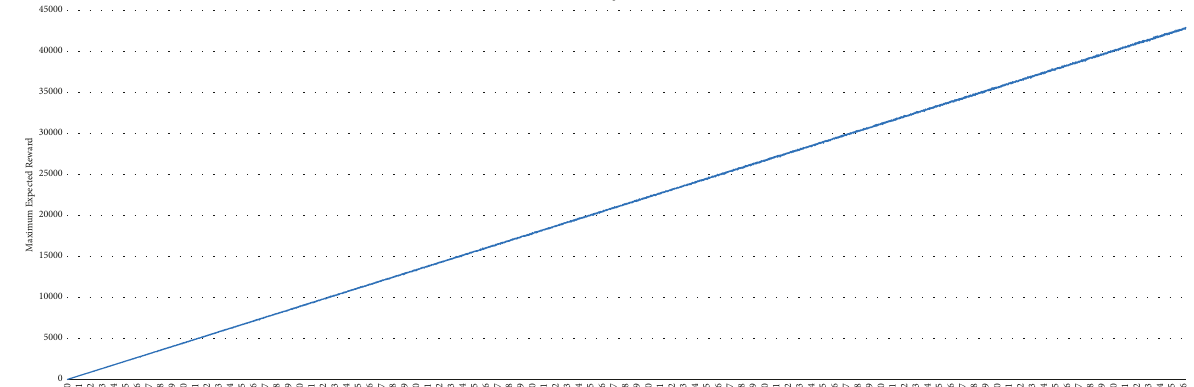
Figure 4: Maximum expected reward for the RL agent interacting with the environment.